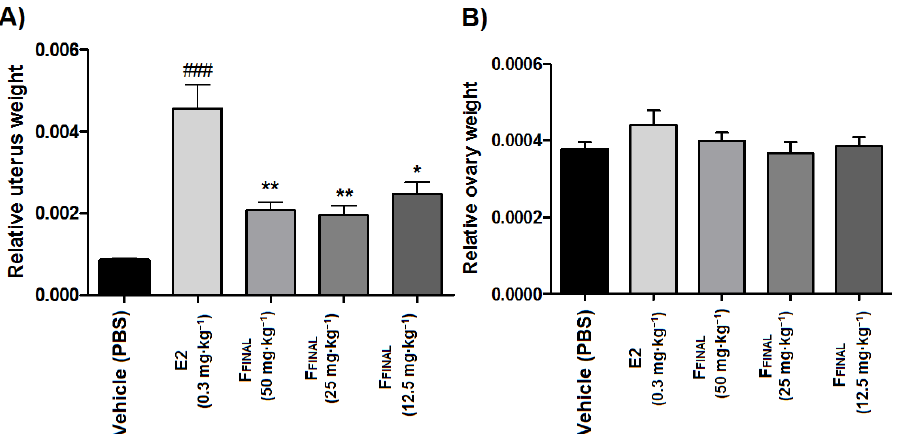
Figure 11. Relative weight of the ( A ) uterus ( B ) ovaries prepubertal Wistar rats after treatment with F FINAL fraction in combination with 17- β -estradiol. Results expressed as mean ± standard deviation; Female Wistar mice ( n = 8 animals / group); Treatments (orally, every three days): vehicle (PBS pH 7.0 + Tween 80, 10 mL · kg − 1 ), F · kg − 1 ), 17 β -estradiol (E2, 0.3 mg · kg − 1 ), fifteen FINAL (12.5, 25, and 50 mg minutes before treatment with F FINAL ; Tukey’s test